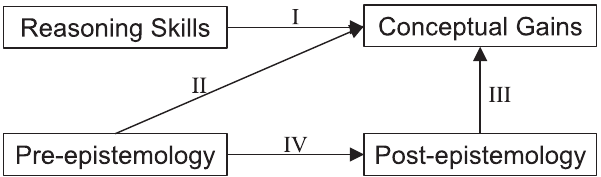
FIG. 1. A causal model of reasoning and epistemology in relation to conceptual learning. Arrows represent influence flow from cause to